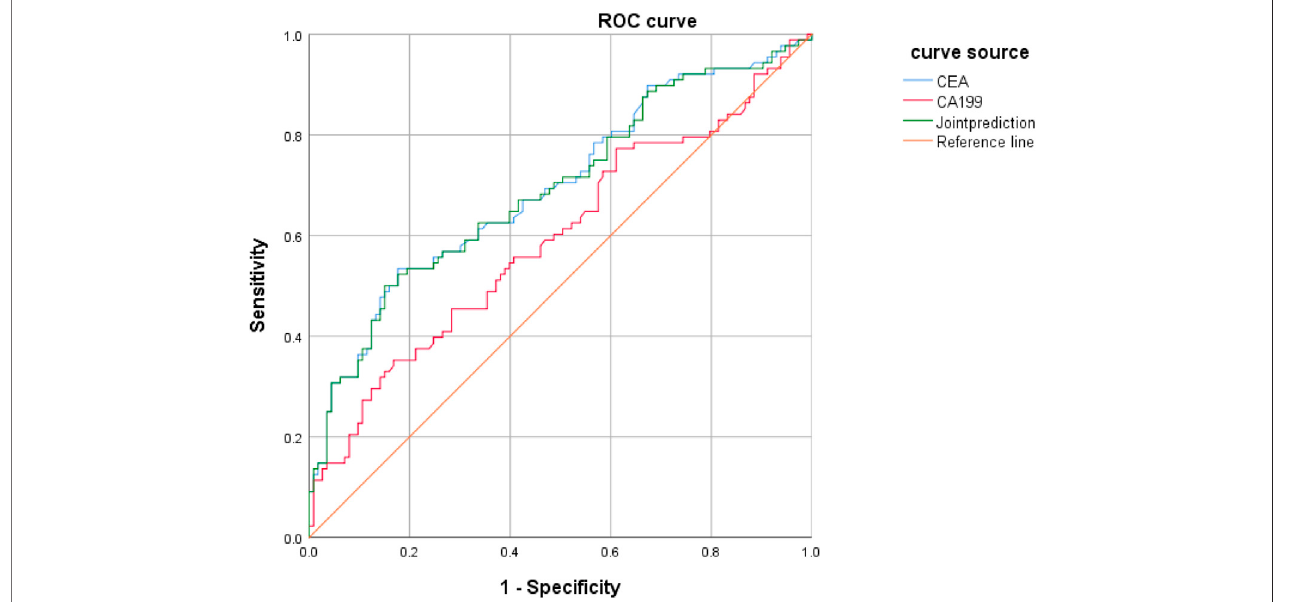
FIGURE 5 | ROC curve in which CEA and CA199 levels indicating colorectal cancer.